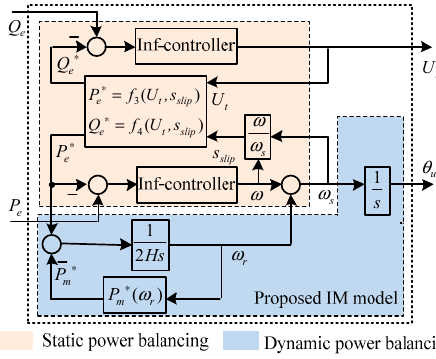
Figure 4. Proposed induction machine model.